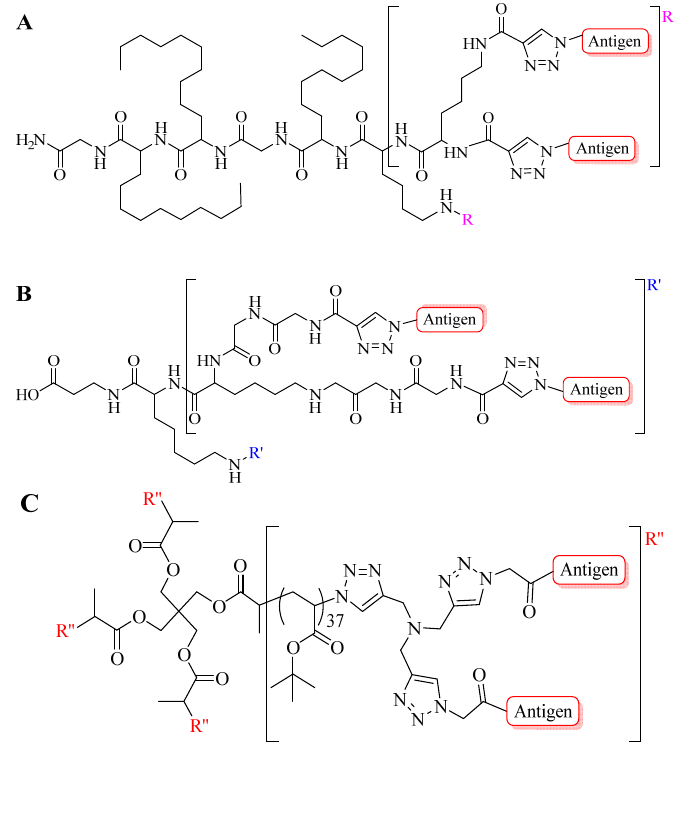
Figure 8. Example of multiple triazole scaffolds synthesized via CuAAC; ( A ) lipid core peptide (LCP), ( B ) dendron scaffold, and ( C ) polymeric